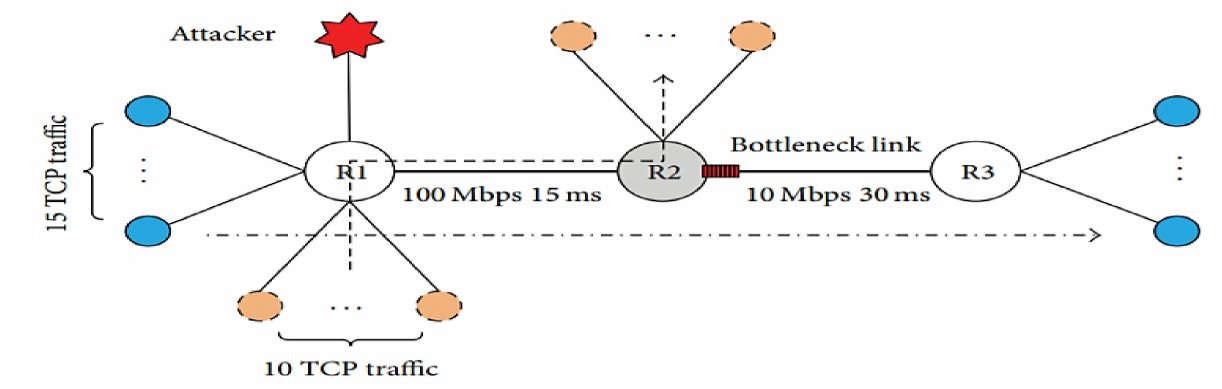
Figure 5. Network topology in NS-2.